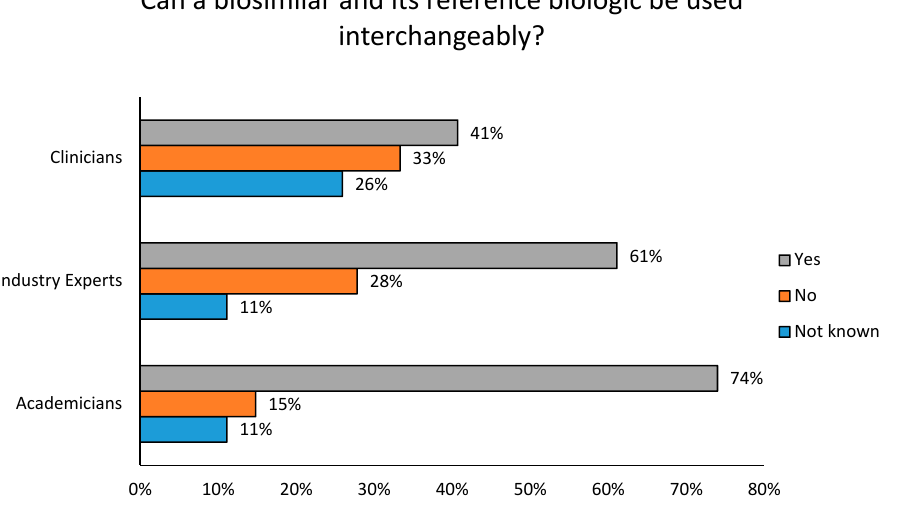
Figure 6. Are biosimilar products interchangeable with their reference biologics? Table 5. Methods of biosimilar reliability demonstration by Industry Experts.